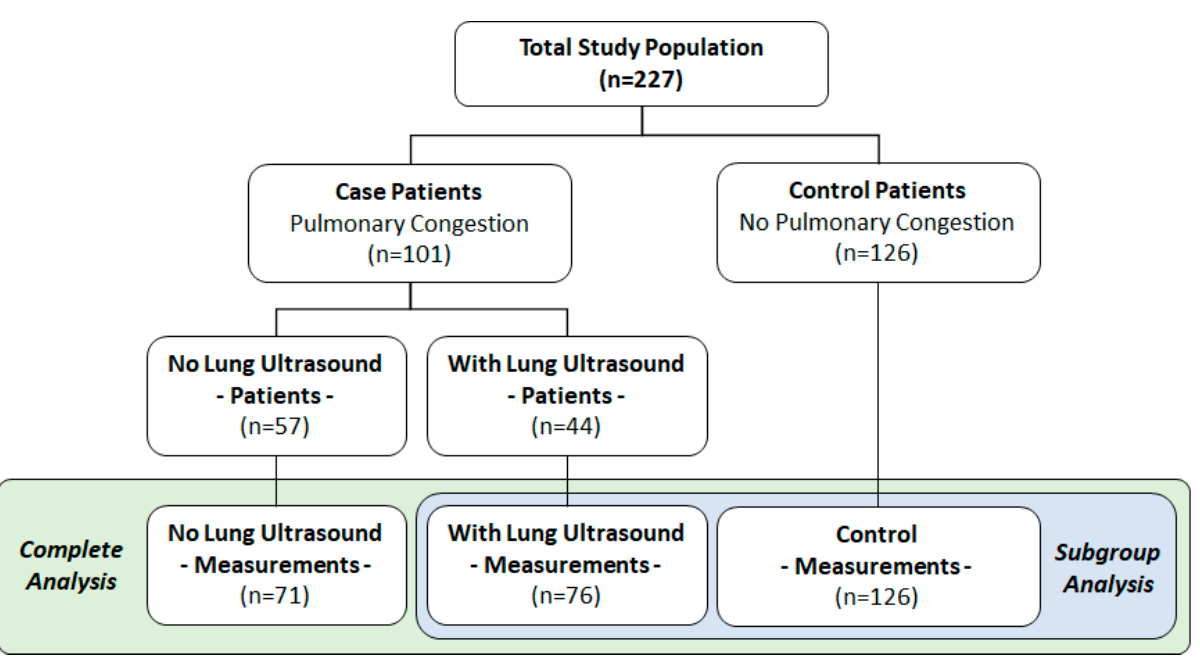
Figure 3. Study flowchart.